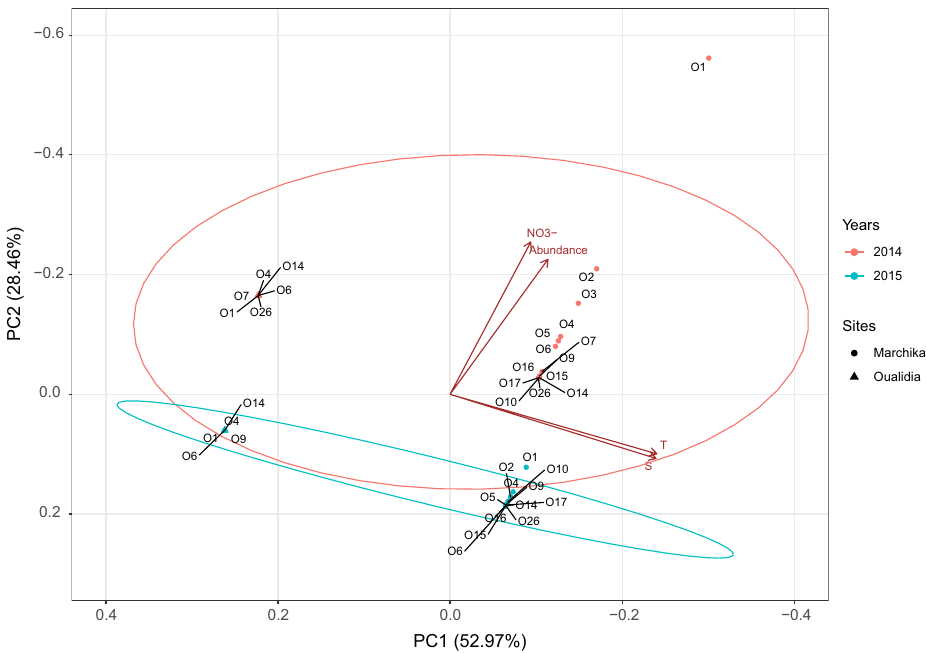
Figure 4. Principle component analysis of Synechococcus oligotype relative abundance. The plot is generated using the relative abundance of each oligotype, T temperature, S Salinity, and NO 3− Nitrate. Each point represents an oligotype. Colors represent the year of sampling; red for 2014 and blue for 2015. The shape of point indicates the sampling site; rounded points refer to Marchica lagoon, and triangles refer to Oualidia. Circles represent the normal distribution of oligotypes; the red circle refers to 2014, and the blue one refers to